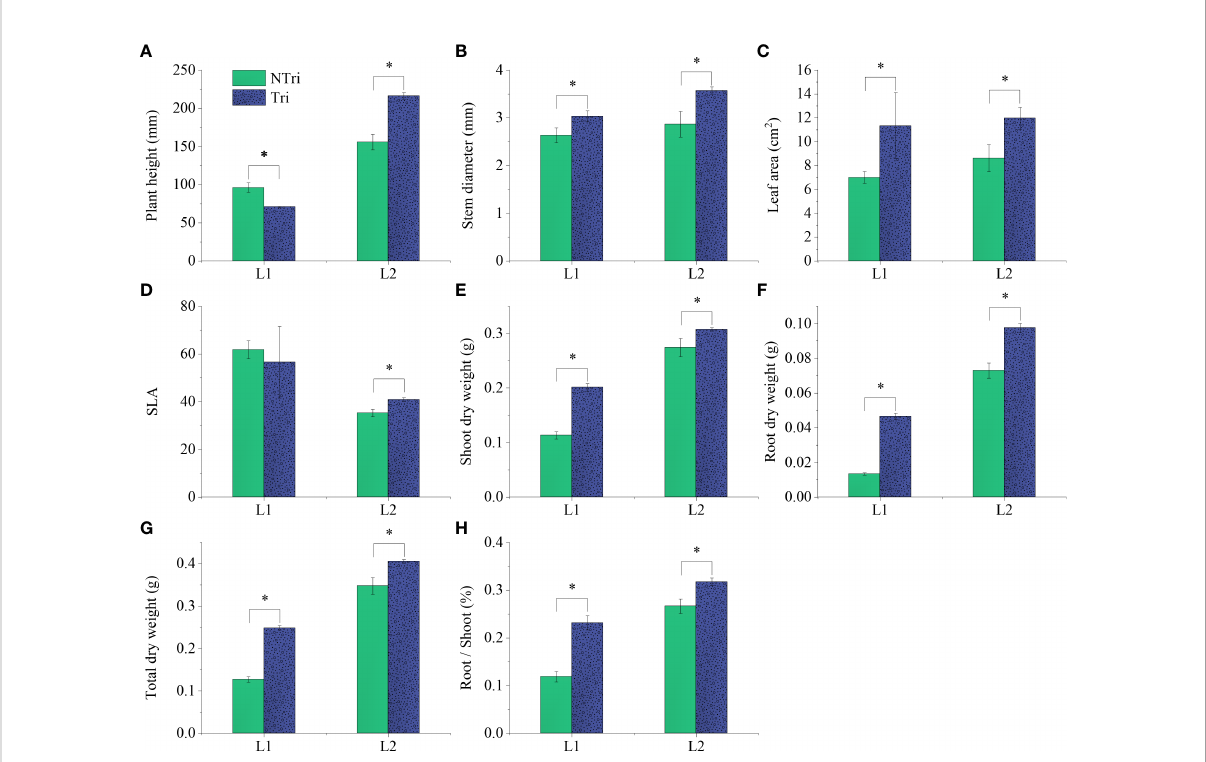
FIGURE 2 Comparing the plant height (A) , stem diameter (B) , leaf area (C) , speci fi c leaf area (D) , shoot dry weight (E) , root dry weight (F) , total dry weight (G) , and root-shoot ratio (H) of the N. benthamiana inoculated or not with Trichoderma . L1 and L2 denote the two light intensities; Tri and NTri denote the treatment groups inoculated and not inoculated with Trichoderma , respectively. Error bars denote standard deviation, and asterisks indicate signi fi cant differences